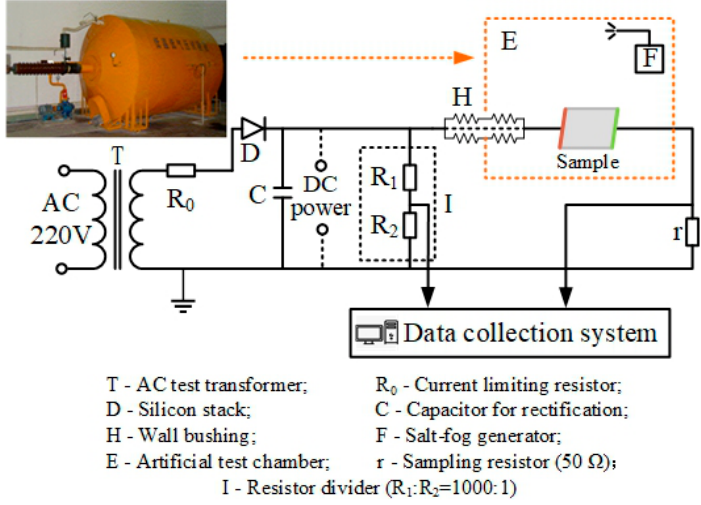
Figure 2. Schematic diagram of DC test circuit.